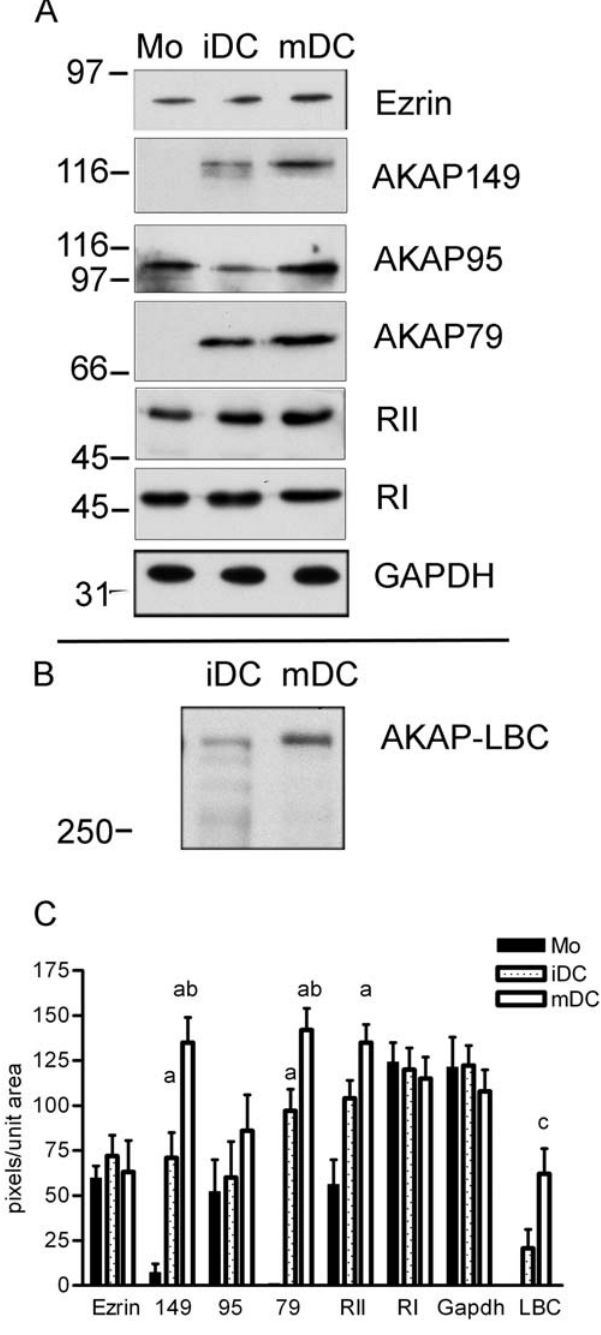
Figure 1. Identification of AKAPs in dendritic cells by western analysis. Monocytes were isolated from PBMC by negative isolation of CD14 + cells (Mo), plated in culture for 5 days with GM-CSF and IL-4 (immature DC; iDC) or plated for five days with GM-CSF and IL-4 and an additional two days with LPS (mature DC; mDC). See Materials and Methods for details. A) One representative set of westerns in which 10 m g total protein was loaded in each lane. Membranes were probed with monoclonal antibodies to AKAP149, AKAP95, AKAP79, RII a , RI a , and GAPDH, goat-anti-mouse HRP conjugated secondary and chemi- luminescence detection. B) One representative western in which 10 m g of total protein was loaded in each lane. The membrane was probed with a rabbit polyclonal antibody to AKAP-Lbc (generous gift of Dr. Diviani), goat-anti-rabbit HRP conjugated secondary and chemilumi- nescence detection. C) Quantitation of five westerns using NIH